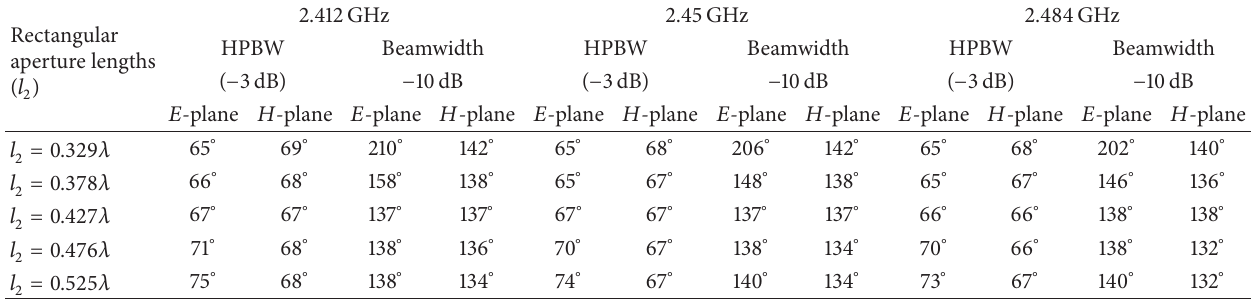
Table 4: Simulated beamwidths at − 3 dB and at − 10dB for various lengths of the parasitic coupling apertures ( 𝑙 2 ) in the 𝐸 - and 𝐻 -planes for the lower, center, and upper frequencies of WLAN.